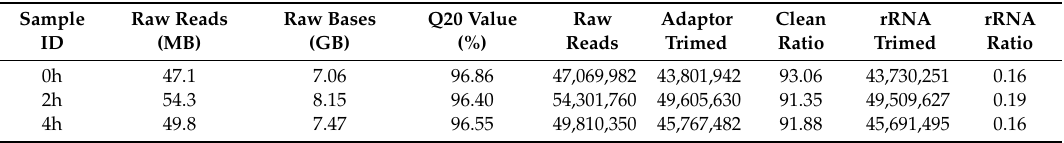
Table 1. Summary of sequencing and assembly data.